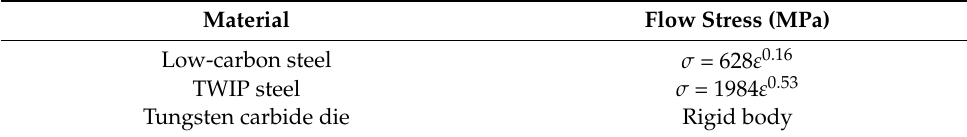
Table 2. Flow stress of wire and die used in this